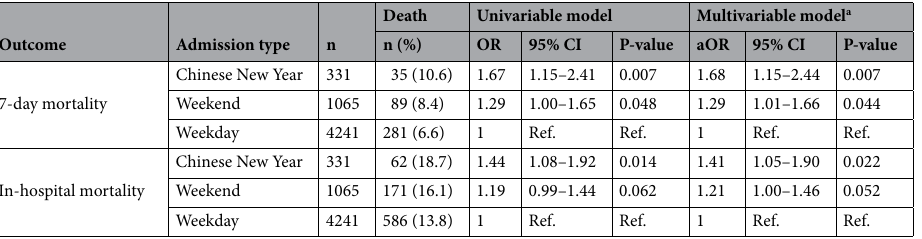
Table 2. Risk of mortality from pulmonary embolism between the three admission groups: Chinese New Year holiday, weekend, and weekday. aOR adjusted odds ratio, CI confidence interval, n number, OR odds ratio, Ref. reference. a Multivariable logistic regression model with adjustments for all covariates listed in Table